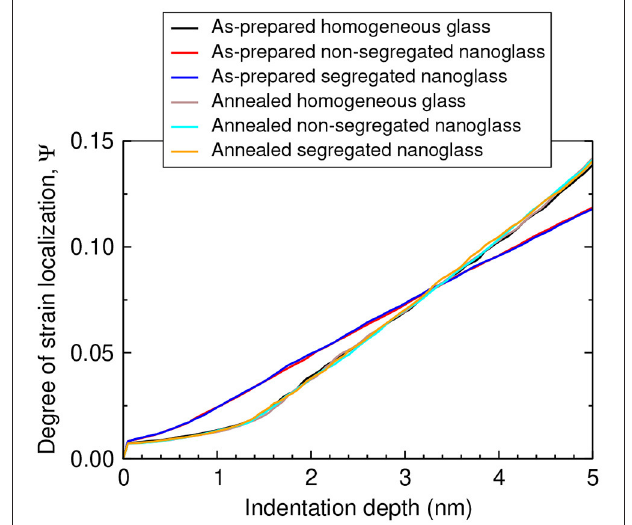
FIGURE 4 | The degree of strain localization parameter, ψ , during nanoindentation of the as-prepared and annealed Cu 64 Zr 36 non-segregated and segregated nanoglasses. As-prepared and annealed homogeneous glasses with identical chemical composition are shown for